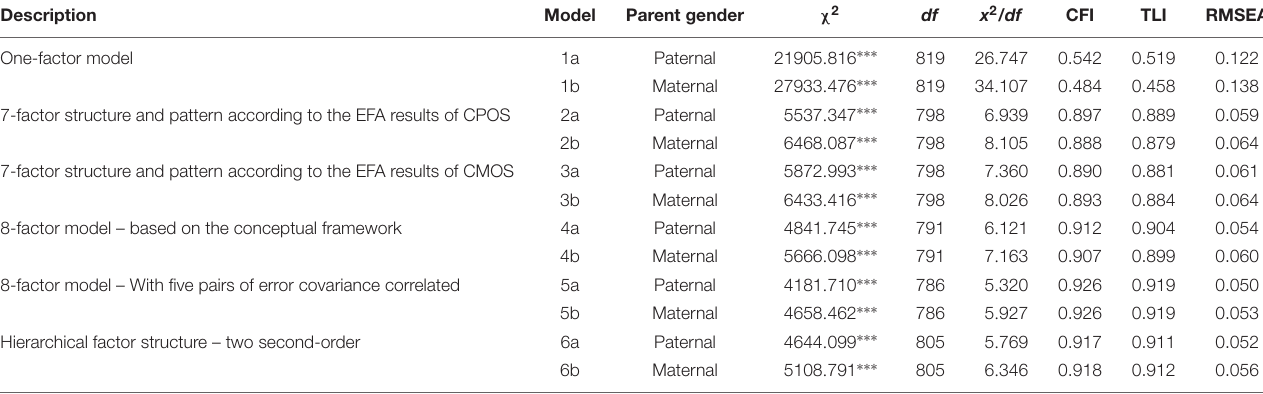
TABLE 5 | Goodness of fit indices for confirmatory factor models and hierarchical factor models of Chinese paternal/maternal overparenting scales.